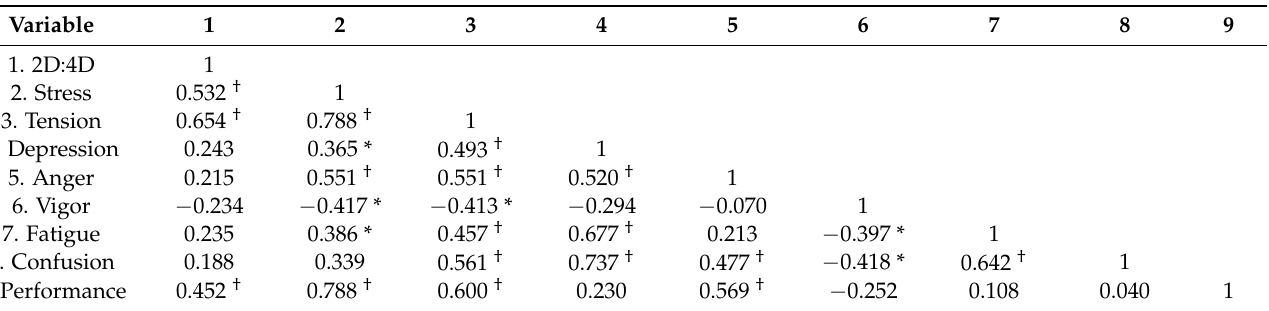
Table 4. Correlation coefficients (Spearman’s